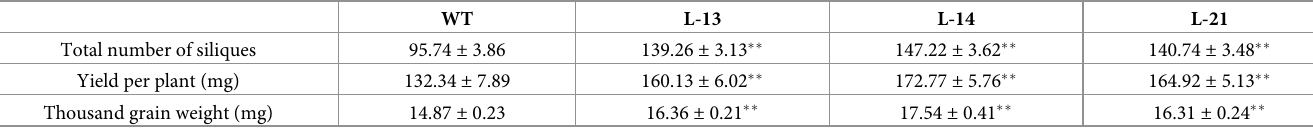
Table 2. Yield-related characteristics of WT and 35S-OsATG8b transgenic